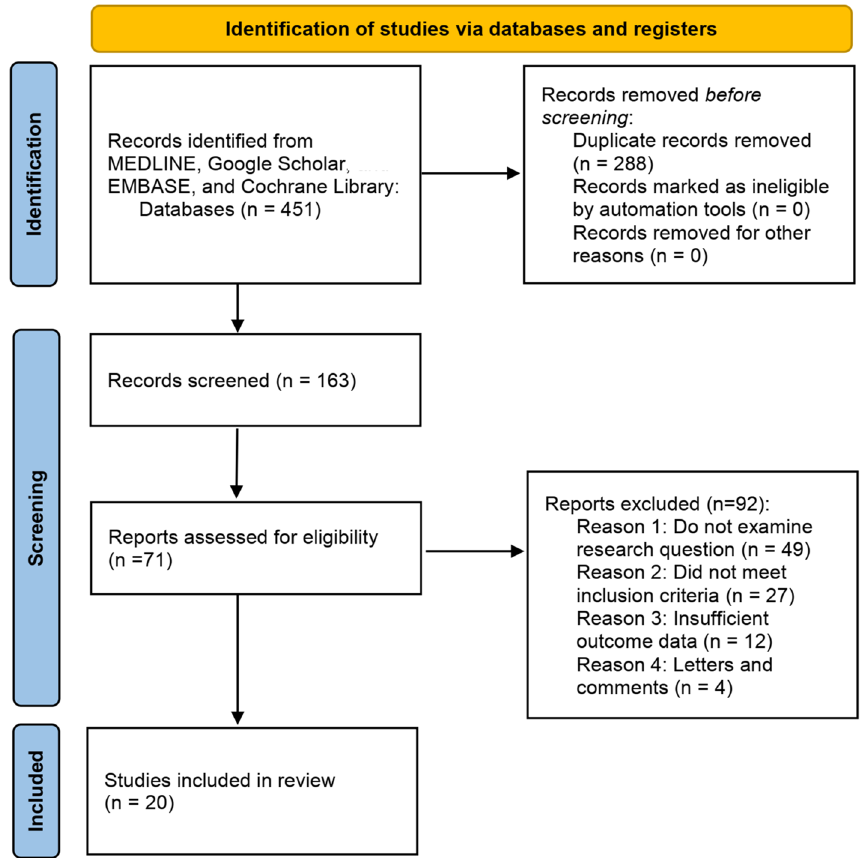
Fig. 1 Search flowchart for identifying the relevant studies reporting use of CoQ10 to treat